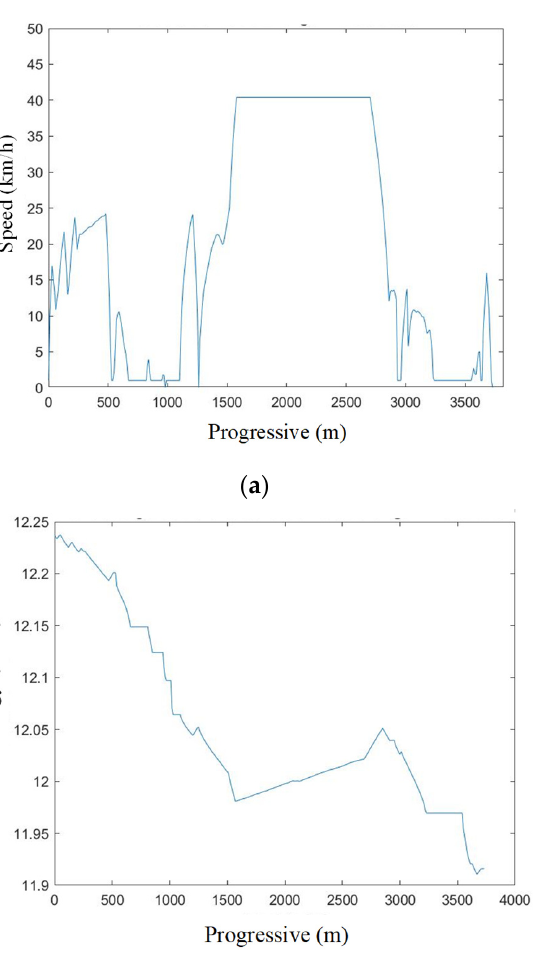
Figure 10. EV-type C performance along route 12: ( a ) Speed profile; ( b ) Power profile; ( c ) Energy profile; ( d ) SOC profile.